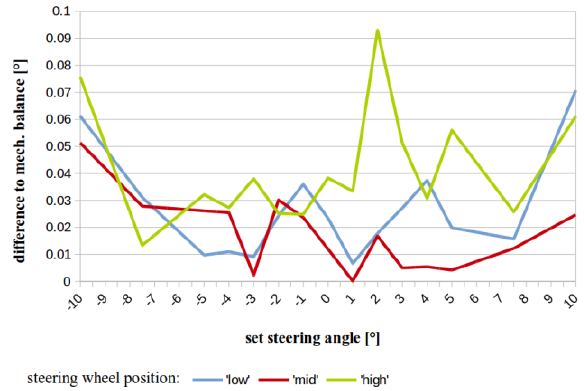
Figure 7. Differences of determined steering angles related